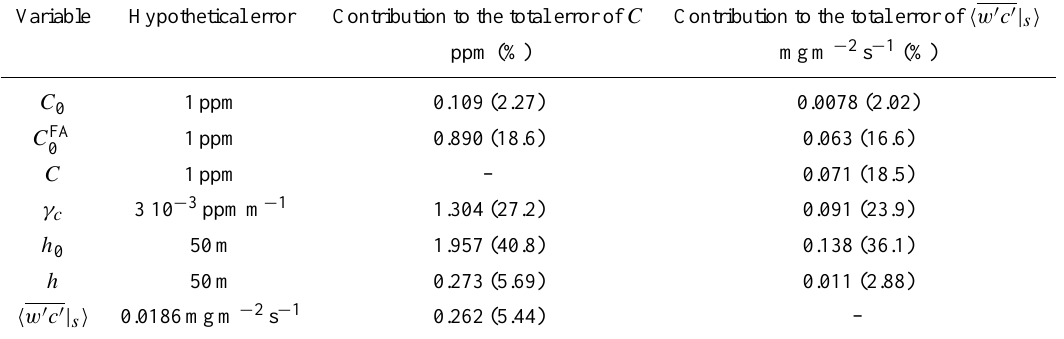
Table 2. Absolute and relative contributions of the error on each variable to the total error of C or h w 0 c 0 | s i at 14:00UTC assuming hypothet- ical constant errors of the different analyzed variables. To calculate the values at the third and fourth columns expression (13) is used with the corresponding value of the sensitivity at 14:00UTC for the CO 2 mixing ratio and the inferred surface flux,